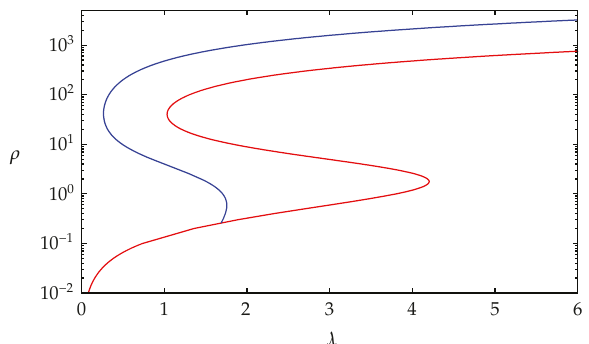
Figure 1: Double S-shaped bifurcation